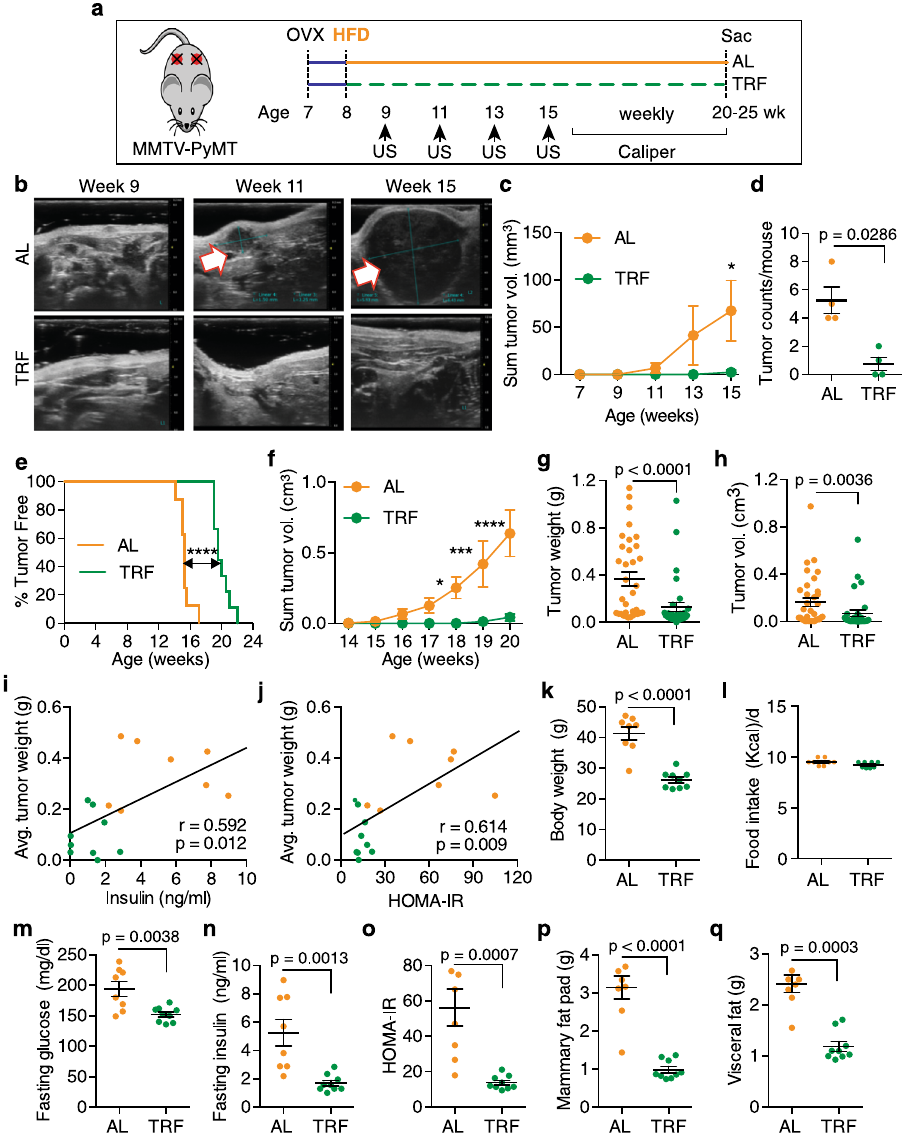
Fig. 4 TRF inhibits tumor initiation and growth in obese OVX-PyMT transgenic mice. a Schematic showing the experimental design. b Representative ultrasound images of mammary fat pads from mice on AL or TRF at post-natal weeks 9, 11, and 15. White arrow indicates a tumor. Data shown are representative of two independent experiments. c Tumor volume measured weekly by ultrasound (number of mice n = 4, * p < 0.05 by two-way ANOVA with Bonferroni ’ s multiple comparisons test). d Number of tumors per mouse at week 15 (number of mice n = 4; two-tailed t test). e Tumor-free survival plot for mice on AL or TRF. Survival analysis was performed by Log-rank (Mantel – Cox) test, **** p < 0.0001, number of mice n = 8 for AL and n = 9 for TRF group. f Total tumor volume per mouse measured weekly with calipers (number of mice n = 8 for AL and n = 9 for TRF; * p < 0.05, *** p < 0.001, **** p < 0.0001 by 2-way ANOVA with Bonferroni ’ s multiple comparisons test). g , h Individual tumor weight and volume at the end of the study (number of tumors n = 34 for AL and n = 32 for TRF; two-tailed t test). i , j Plots showing correlation of mean tumor weight per mouse vs. fasting insulin level or HOMA-IR (number of mice n = 8 for AL and n = 9 for TRF). Data were analyzed by linear regression using Pearson correlation. k Body weight at end of study (number of mice n = 8 for AL, n = 9 for TRF; **** p < 0.0001 by two-tailed t test). l Caloric intake ( n = 8), m – o Fasting blood glucose, insulin, and HOMA-IR at end of study (number of mice n = 8 for AL, n = 9 for TRF; two-tailed t test). p , q Mammary and visceral fat tissue weight at end of study (number of mice n = 8 for AL, n = 9 for TRF; two-tailed t test). Data presented as mean ± SEM. Asterisks show statistical signi fi cance between AL and TRF. AL mice are labeled in orange, and TRF mice in